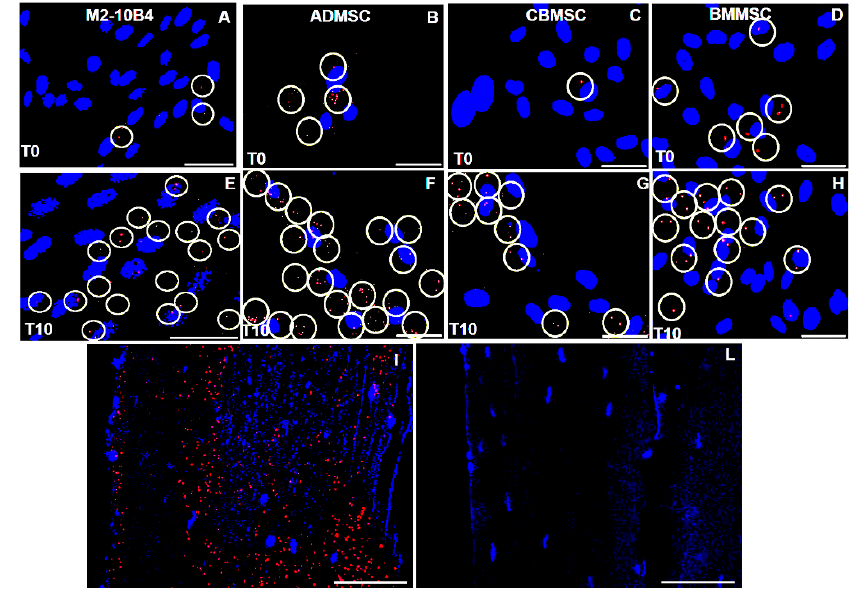
Figure 7. The white circles highlight the cell localization of Fetuin-A/FGF23 interaction detected by a Duolink in situ experiment in M2-10B4 ( A , E ), ADMSC ( B , F ), CBMSC ( C , G ), and BMMSC ( D – H ) during the osteogenic induction from T0 to 10 days. FGF23 /Fetuin-A interaction in mice tibial bone tissue detected by Duolink in red, and DAPI for the cells localization in blue ( I ), control negative ( L ). Scale bar = 50 μ m.